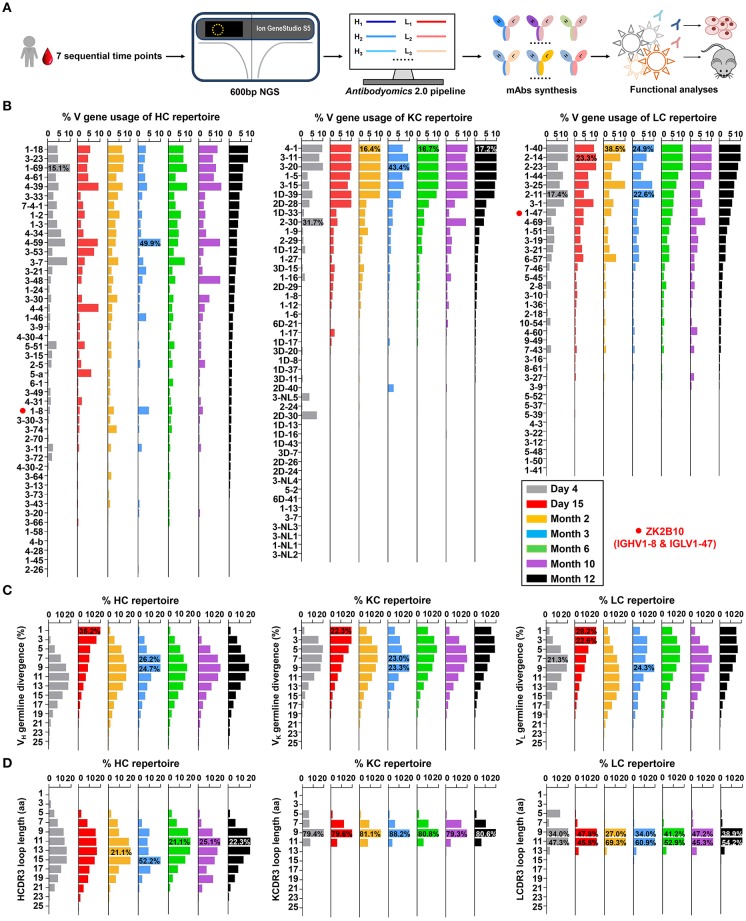
Unbiased antibody repertoire profiles of donor Pt1 across ZIKV infection. (A) Schematic view of unbiased antibody repertoire analysis and ZK2B10 lineage tracing. PBMC samples from Pt1 were collected at 7 sequential time points after the onset of symptoms. 5′-RACE PCR was used to prepare antibody chain libraries for long-read (600 bp) next-generation sequencing (NGS) on the Ion GeneStudio S5 platform. The Antibodyomics 2.0 pipeline was used to process the NGS data for antibody repertoire profiling, while CDR3-based identification was used for ZK2B10 lineage tracing. Representative somatic variants were synthesized for functional characterization. (B–D) Distributions were plotted for (B) germline V gene usage, (C) germline divergence, and (D) CDR3 loop length for heavy chains (left panel), κ chains (middle panel), and λ chains (right panel). Color coding denotes the 7 sequential time points with Day 4 shown in gray, Day 15 in red, Month 2 in orange, Month 3 in sky blue, Month 6 in green, Month 10 in purple, and Month 12 in black. The germline V genes used by ZK2B10 (IGHV1-8 and IGLV1-47) are marked with red dots.